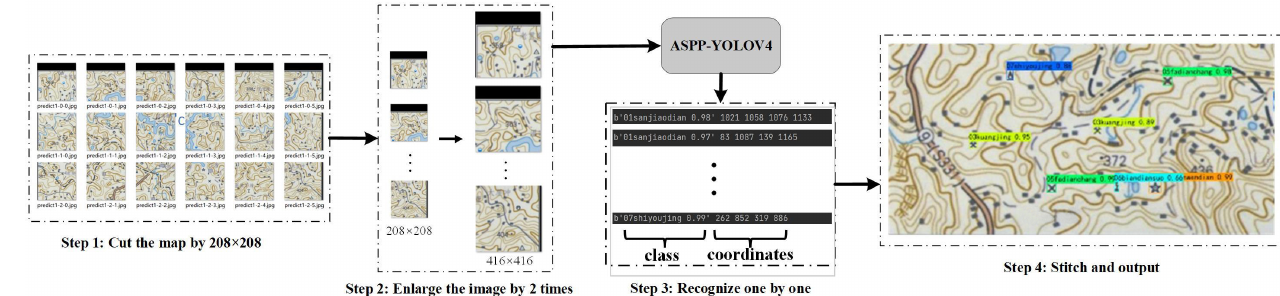
Figure 19. Symbol detection processing operation for large-scale maps: “first cut, then zoom, detect, and finally